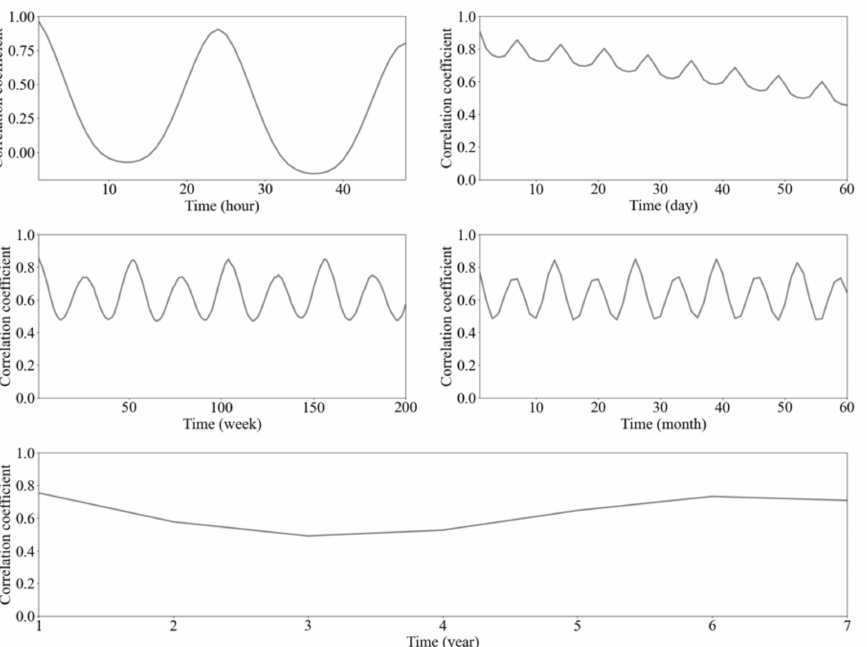
Figure 1. Pearson correlation coefficient of load data corresponding to hour, day, week, month, and